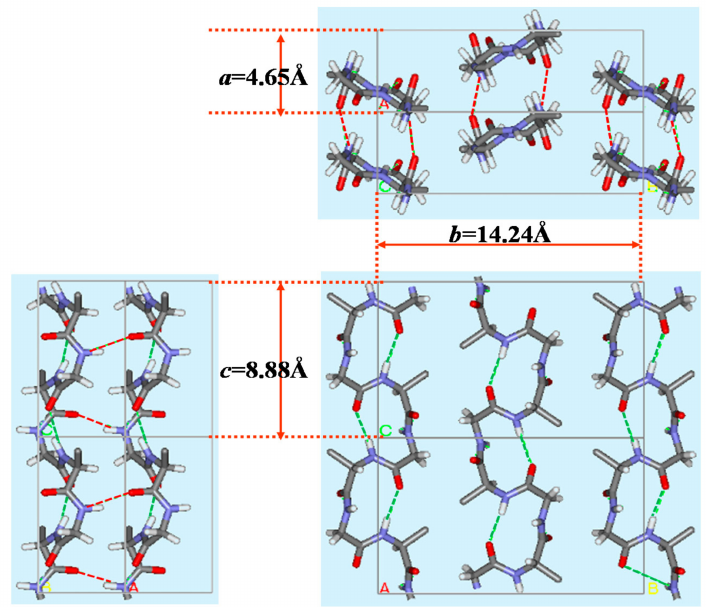
Figure 7. Packing structure of poly(AG) chains with type II β − turn structure as a model for silk I. Dotted lines denote intra-(green) and inter-(red) molecular hydrogen bonds. The unit lattice values, a , b and c were obtained from X-ray diffraction data [21,22]. Reprinted with permission from ref. 22. Modified from ref. 22.